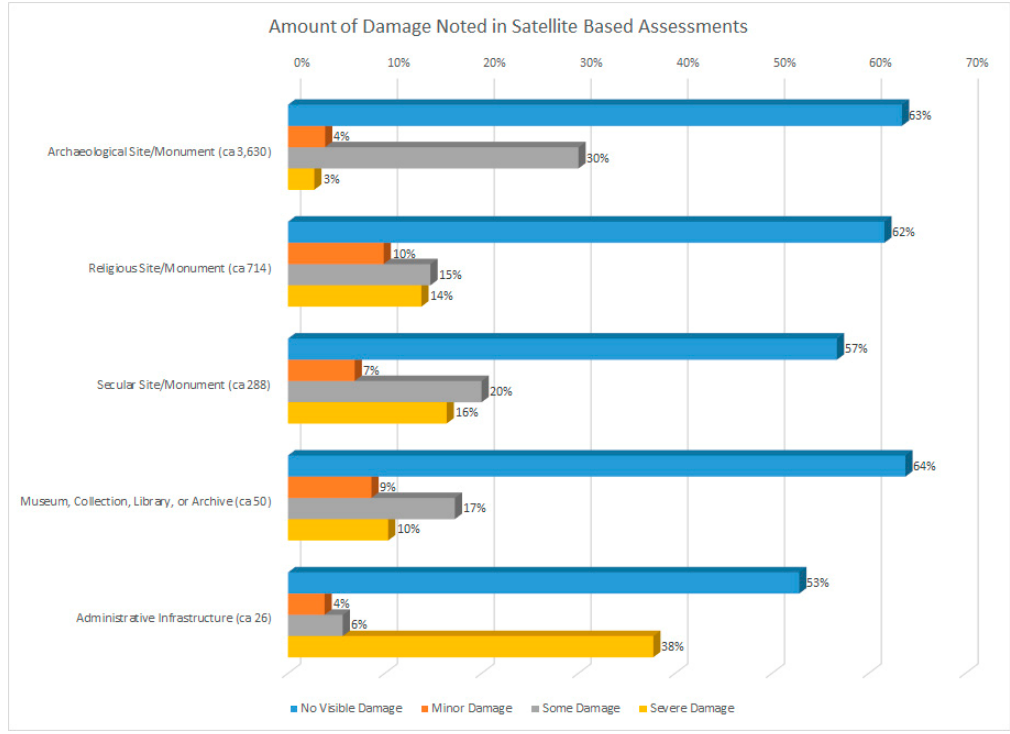
Figure 1. Satellite based assessments of heritage sites within the Cultural Heritage Initiatives (CHI) Inventory (mainly Syria and northern Iraq) according to site types and levels of assessed damage (ASOR CHI; 26 July 2017).